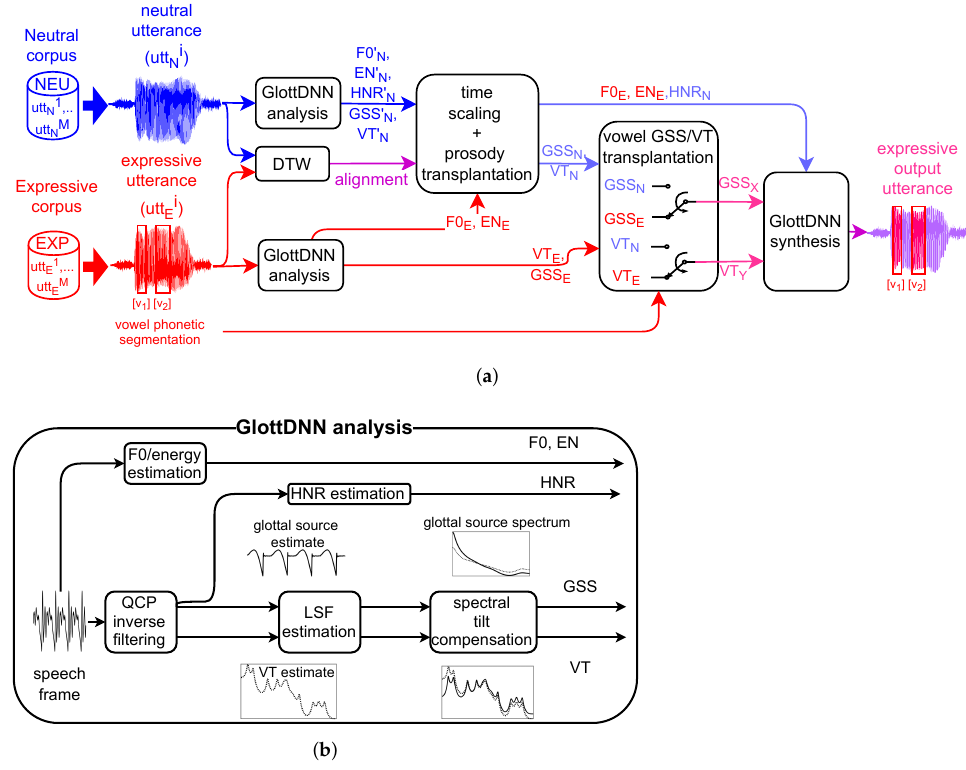
Figure 2. Block diagram of the analysis-by-synthesis methodology designed to evaluate the contribu- tions of vocal tract and glottal source spectral cues (VT and GSS) in the generation of voice-expressive (EXP) vowels. M pairs of neutral and expressive utterances from a parallel speech corpus are pa- rameterised with the GlottDNN vocoder, and aligned through dynamic time warping (DTW). Next, the features of each neutral utterance utt i (marked with (cid:48) ) are time-scaled according to the DTW N alignment, and transplanted with the F0 E and EN E of the expressive pair utt i counterpart. The E final step is GlottDNN-based synthesis, which generates different expressive output utterances by applying GSS X and VT Y to their vowels—being X , Y either neutral (N) or expressive (E). ( a ) Overall diagram of the analysis-by-synthesis methodology. ( b ) Details of the GlottDNN